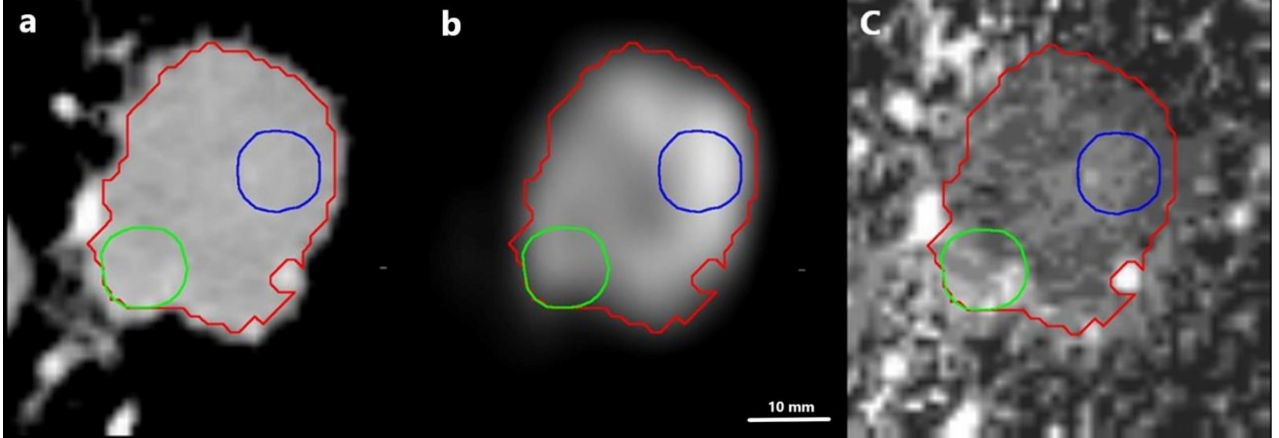
Figure 6. Illustration of the distance between the SUV peak ROI (blue outline) and the Iodine peak ROI (green outline) in a patient with a tumor of 21 cm 3 (red outline). The distance between the two peak ROIs was 21 mm. ( a ): Iodine concentration map, ( b ): SUV map, ( c ): overlay of iodine concentration map and SUV